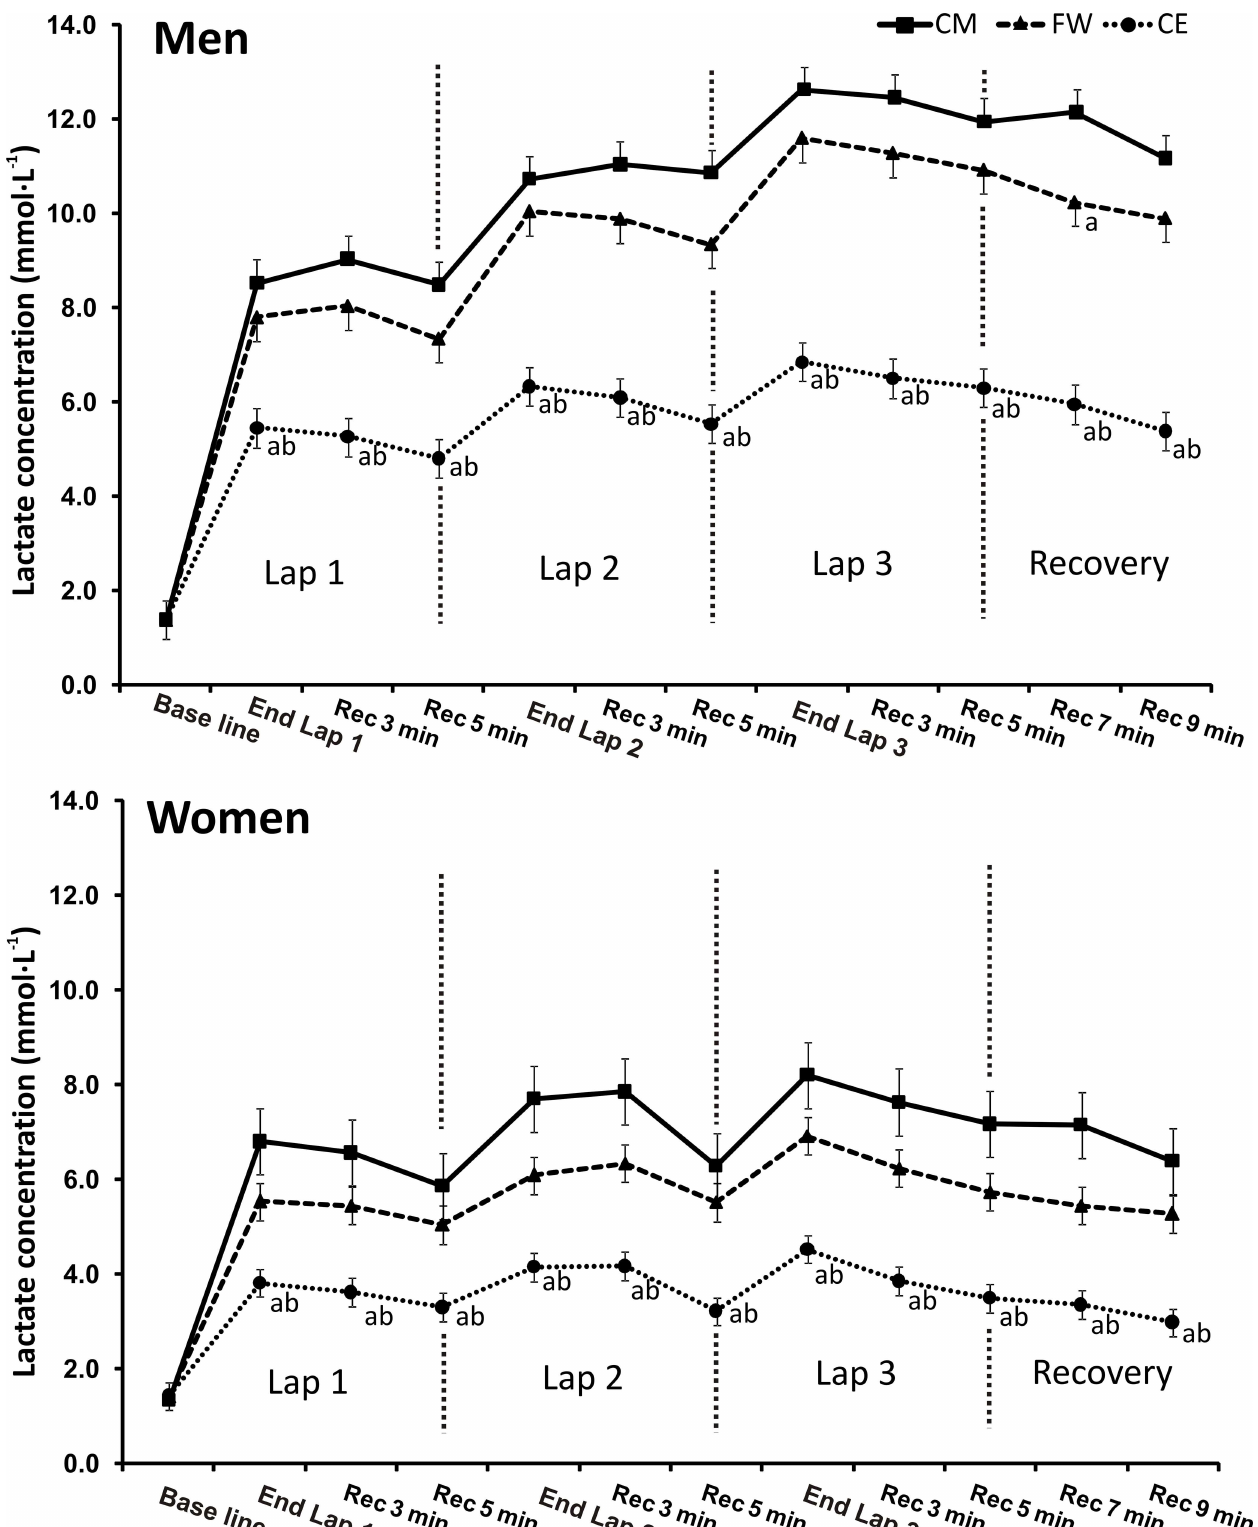
Fig 2. Blood lactate concentration measurements (mmol (cid:1) L -1 ) during training protocols. CM: Circuit Machine trainingprotocol; FW: Free Weight-training protocol; CE: Combined Exercise training protocol. Data are reported as mean ± SEM for women (n = 14) and men (n = 15). a p < 0.05 with CM. b p < 0.05 with